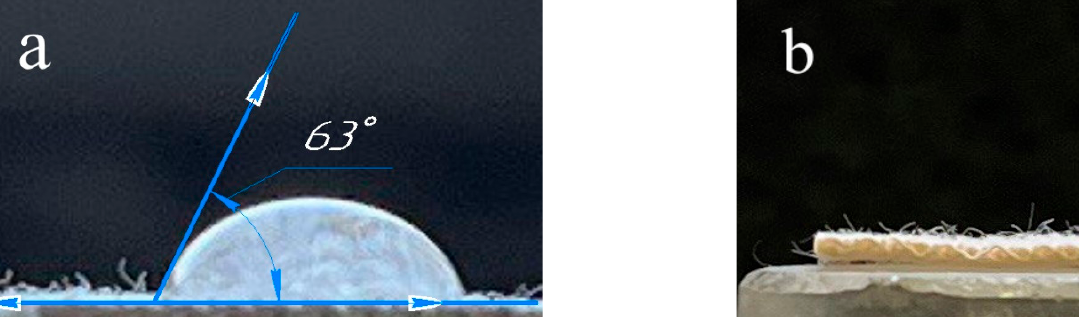
Figure 3. Photos of a sessile drop of ( a ) water and ( b ) the complete spreading of ethanol on the surface of phosphorylated cotton fabric.